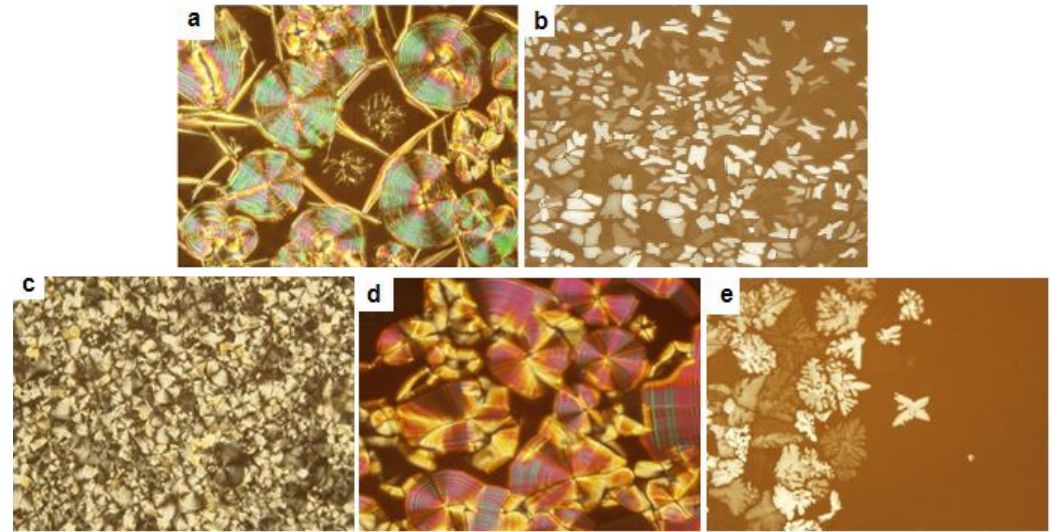
Figure 1. Representative optical polarized micrograph (×100) of the texture exhibited by ( a ) hexagonal perforated lamellar structure of 1a in the crystal phase; ( b ) Rectangular columnar structure of 1a and ( c ) oblique columnar structure of 1a at the transition from the anisotropic liquid crystal phase; ( d ) 3-D hexagonal close-packed structure of 1b at the transition from the anisotropic liquid crystalline phase; ( e ) Body-centered tetragonal micelle of 1c at the transition from the anisotropic liquid crystalline